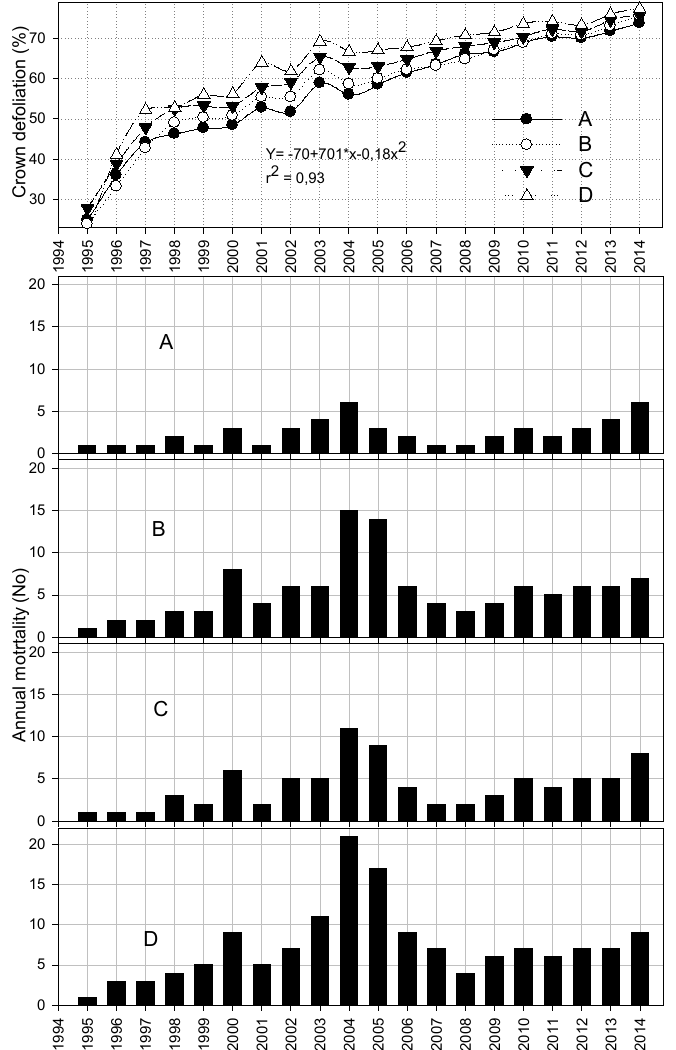
Figure 5. The average crown defoliation on all pedunculate oak plots (1995–2014, n = 192 adult trees, 48 per plot) with standard deviation (above) and corresponding total annual mortality rate (No/ha, below), on every plot (A, B, C and